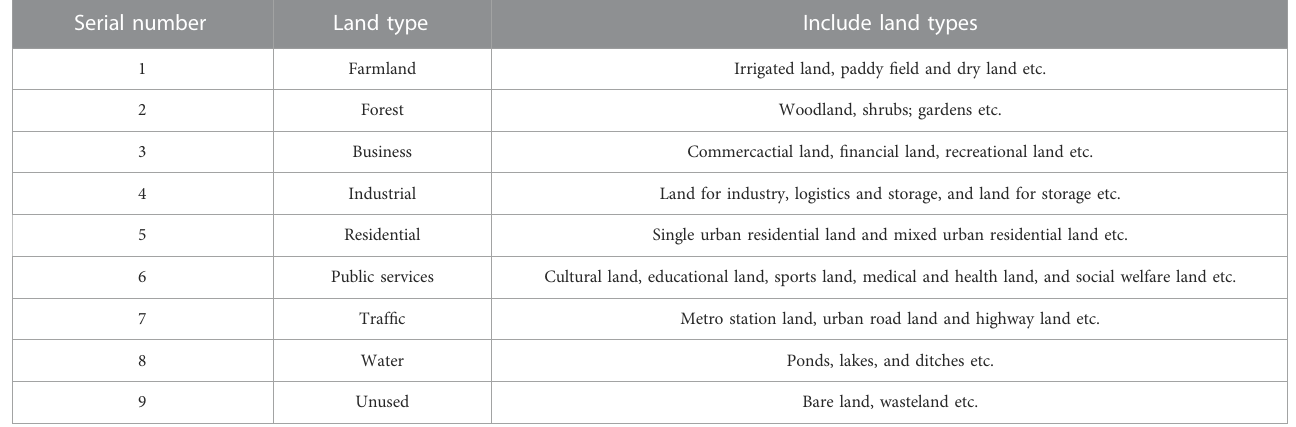
TABLE 1 Classi fi cation of land use types in the study